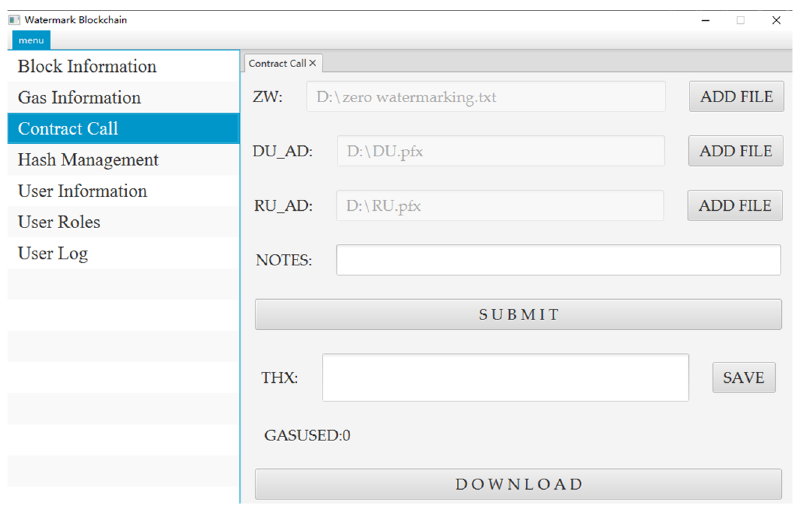
Figure 10. The interface of the blockchain certificate storage system.